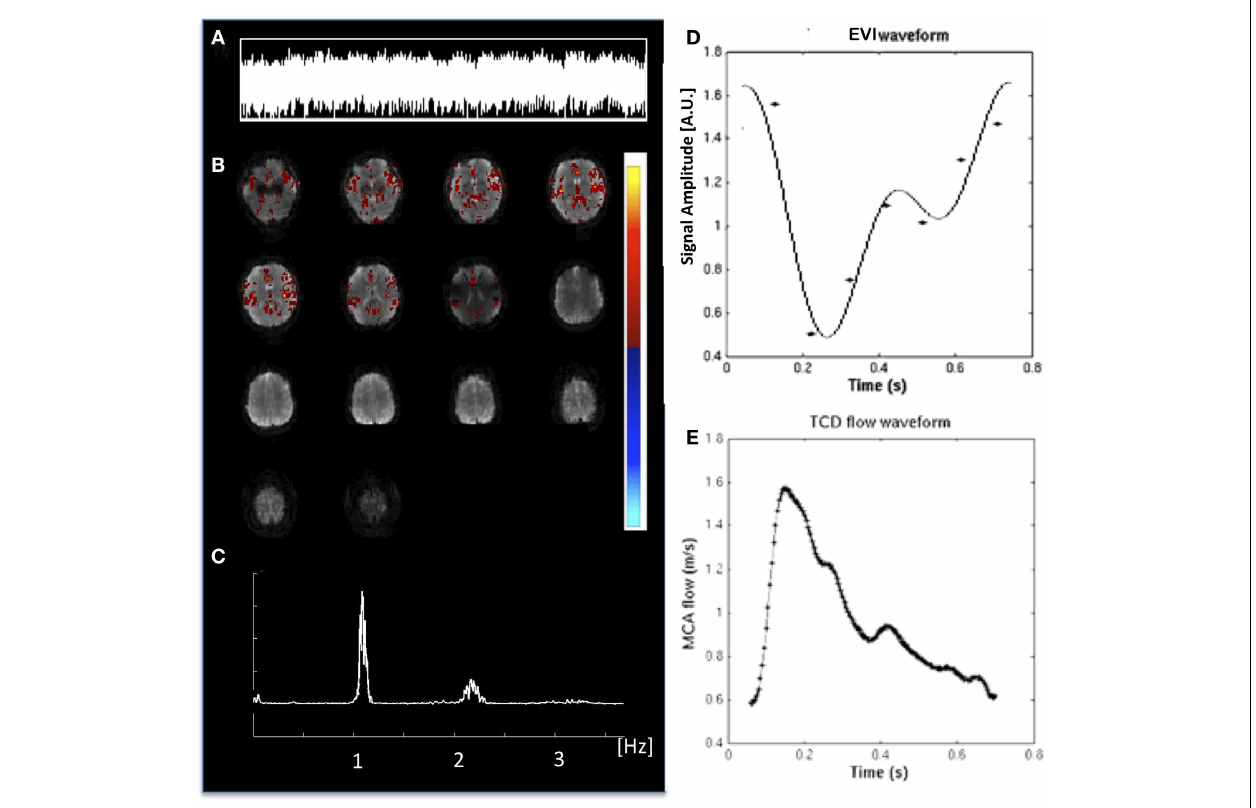
Corresponding raw power spectrum shows the cardiac frequency and its first harmonic. (D) Fitted MEVI2 signal time course, which is inverted with respect to (E) a typicalTranscranial Doppler Ultrasound waveform from the middle cerebral artery (fromWagshul et al.,